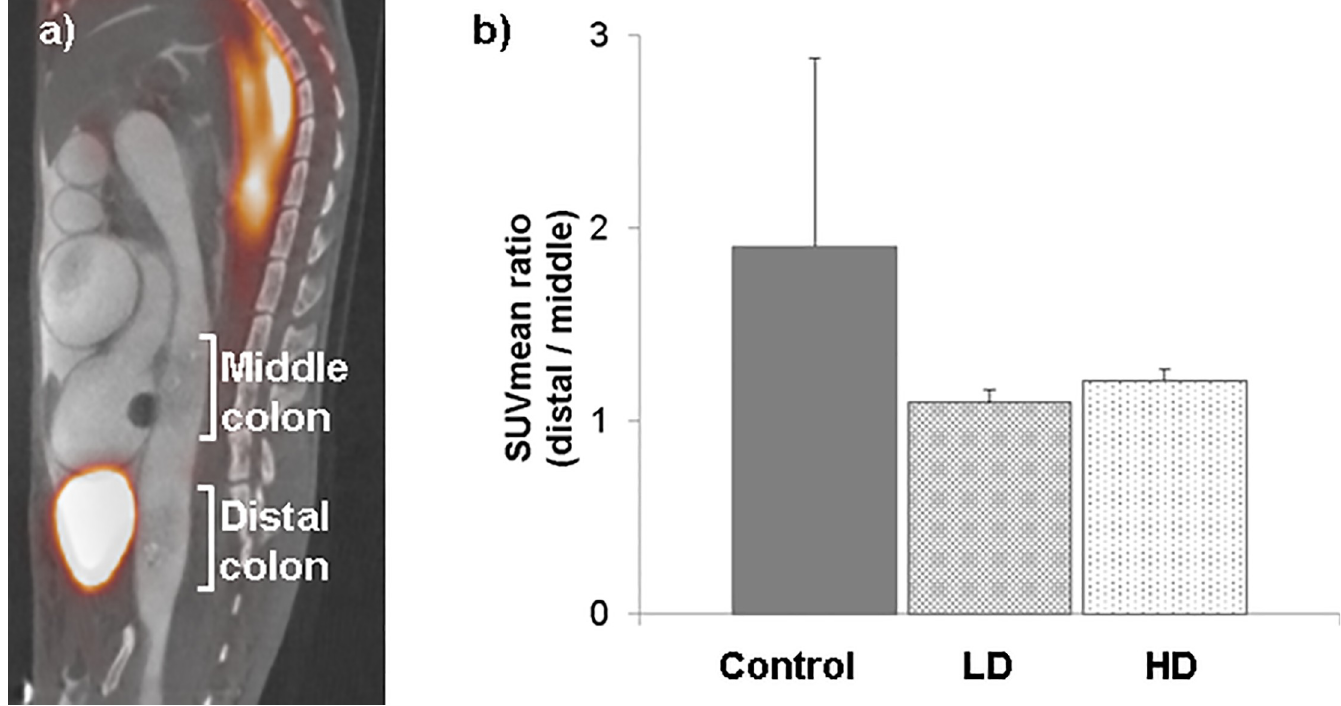
Fig 3. Evaluation of bladder spillover. (A) Sagittal PET (red scale) and CT (grey scale) image of mouse abdomen showing selected areas of the colon. (B) Ratio between the distal colon and middle colon (n = 3 per group). HD, high furosemide dose (7 mg/kg); LD, low furosemide dose (3.5 mg/kg).